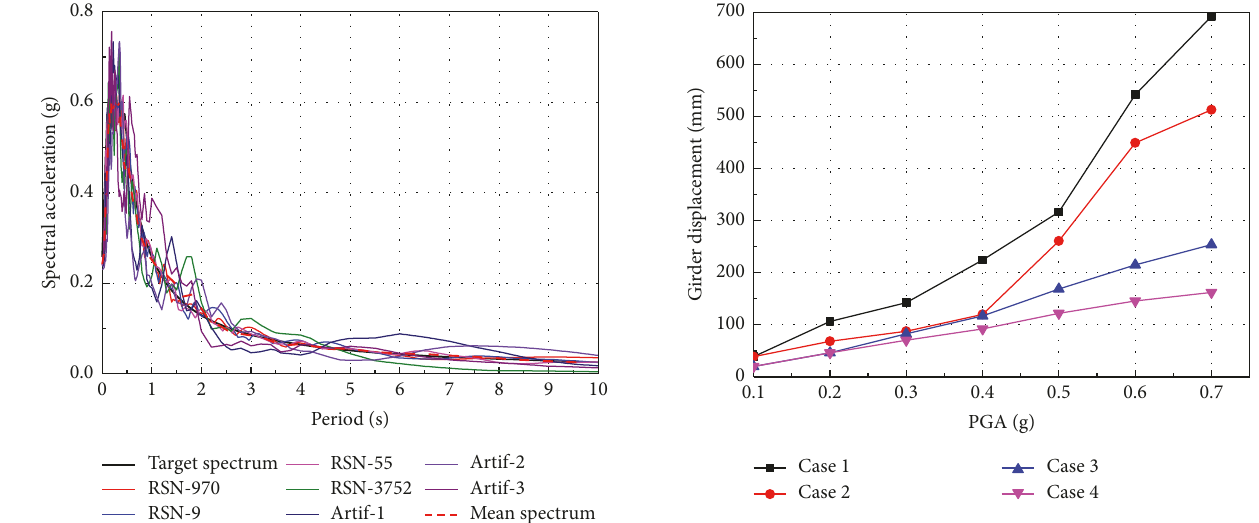
Figure 20: Maximum girder